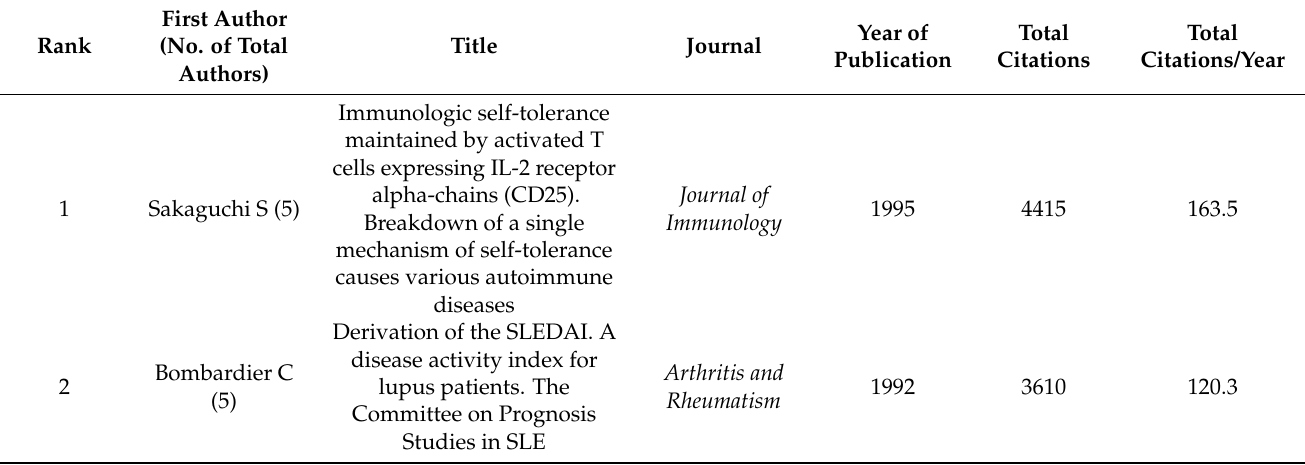
Table 4. The top 10 original articles based on the number of citations in systemic lupus erythematosus research between 1971 and